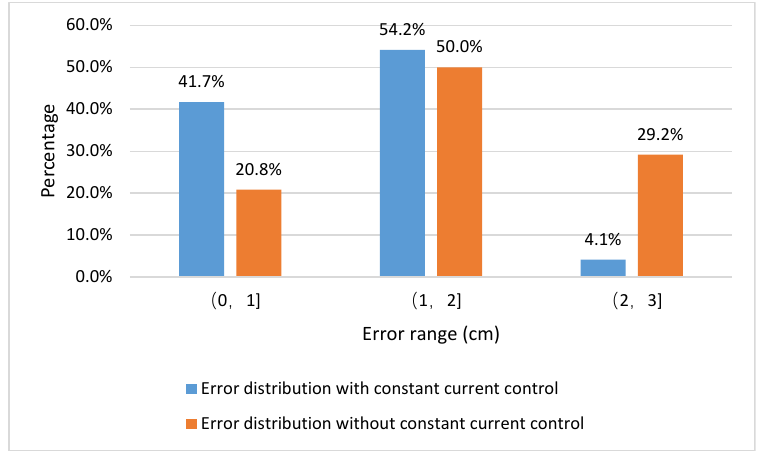
Figure 16. Comparison of positioning error distribution.